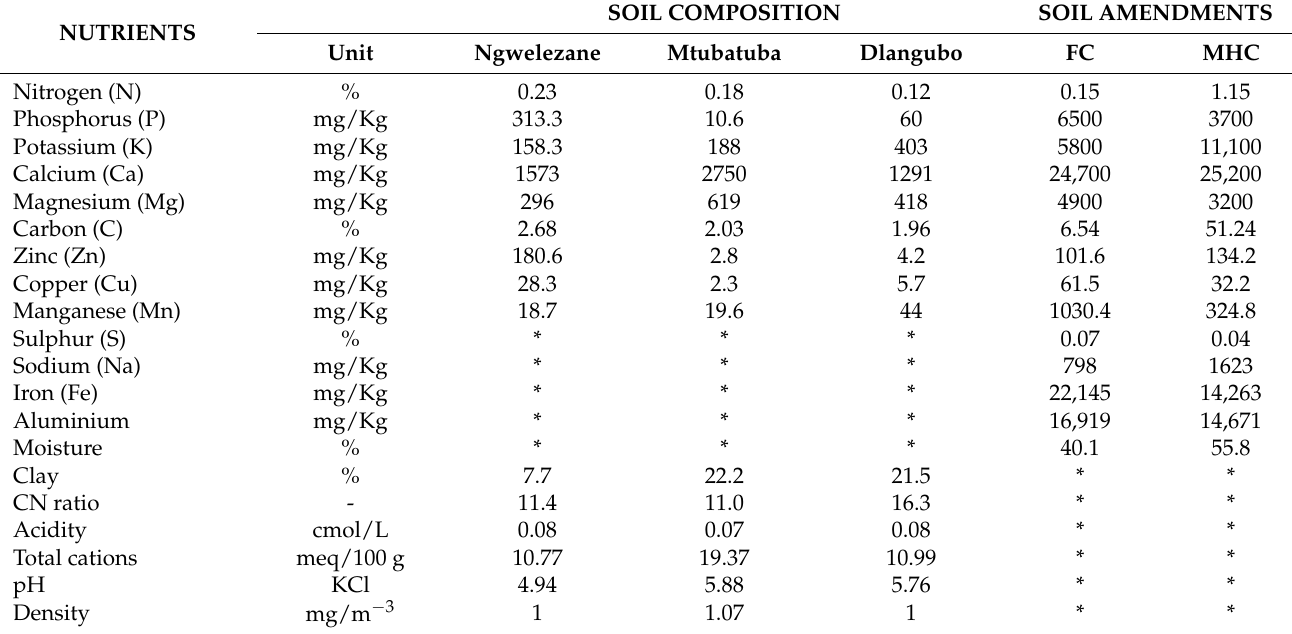
Table 2. Initial chemical composition of the Ngwelezane, Mtubatuba, and Dlangubo sites’ soil and that of filter cake and macadamia